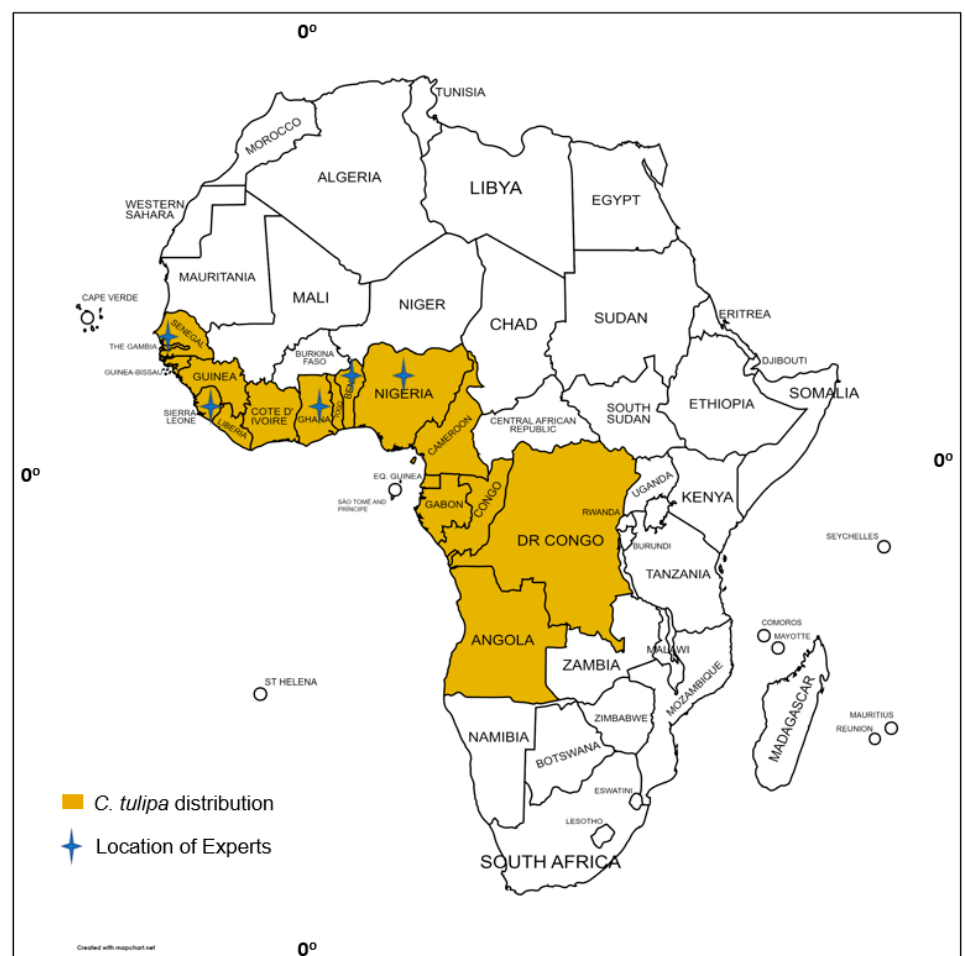
Figure 2. Spatial region of the vulnerability assessment and locations of experts.